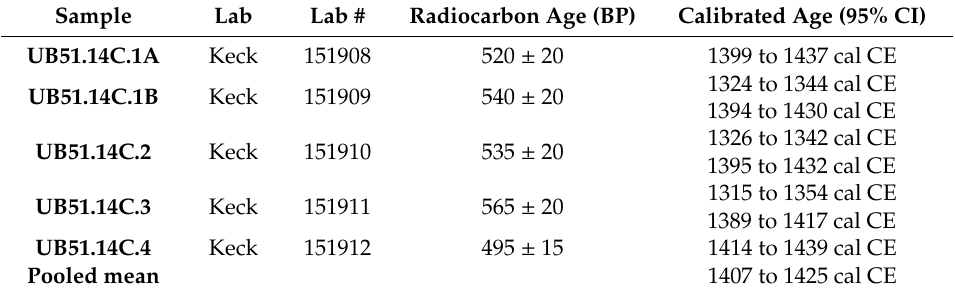
Figure A6. Radial plots of OSL measurements of ceramics from animal burrows or looters pits that never burned in historical or modern wildfires. Table A1. Accelerator mass spectrometry measurements of maize cob fragments from Wabakwa.